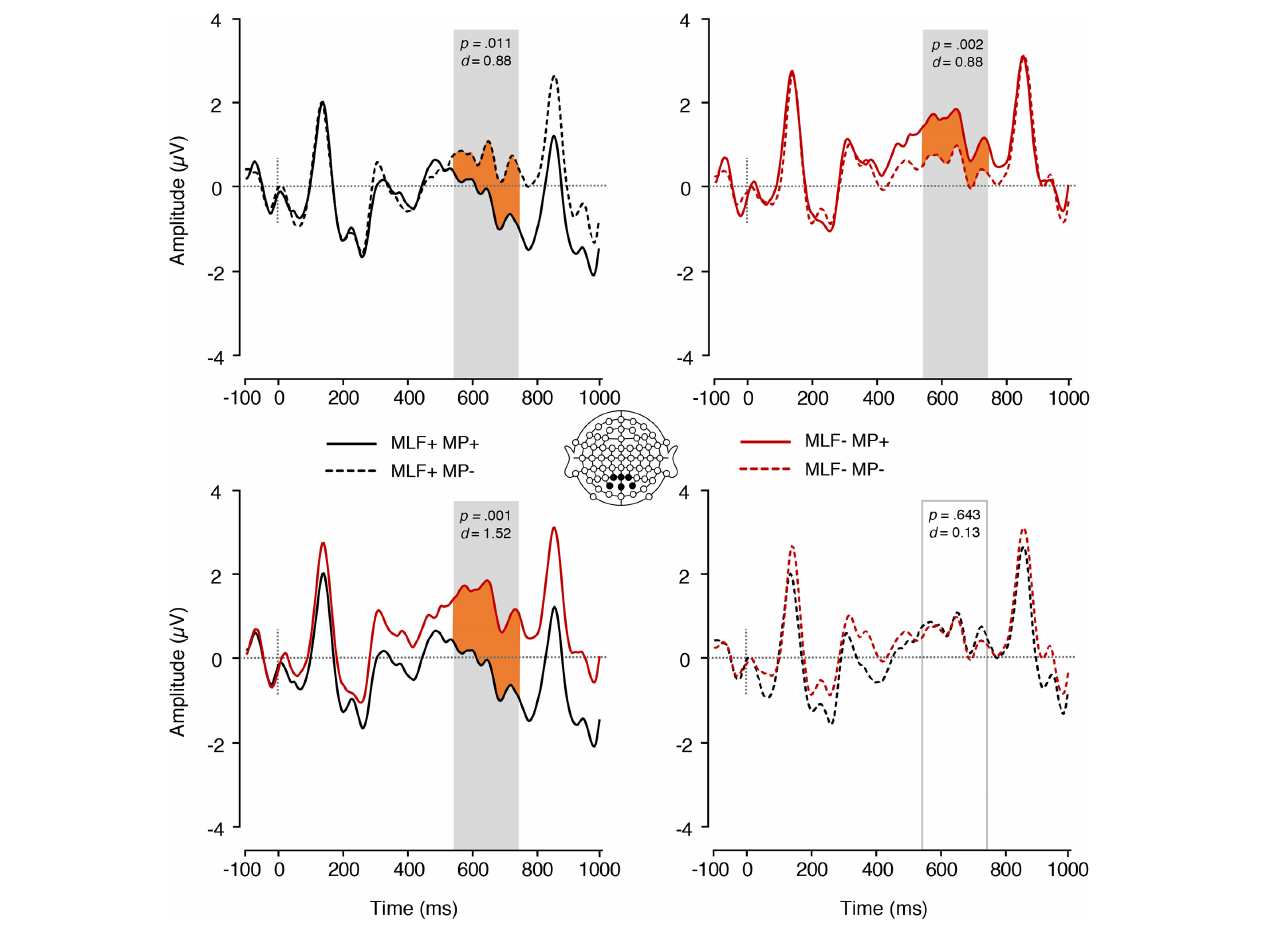
FIGURE 8 | ERPs elicited by all adjectives, depicting the interaction between MLF and MP. The plain grey box indicates the time window of the analysis in which mean ERP amplitudes significantly differed between conditions (550–750 ms post-stimulus). MLF, Matrix Language Framework; MP, Minimalist Programme; +, stimuli compliant with prediction; –, stimulus violating